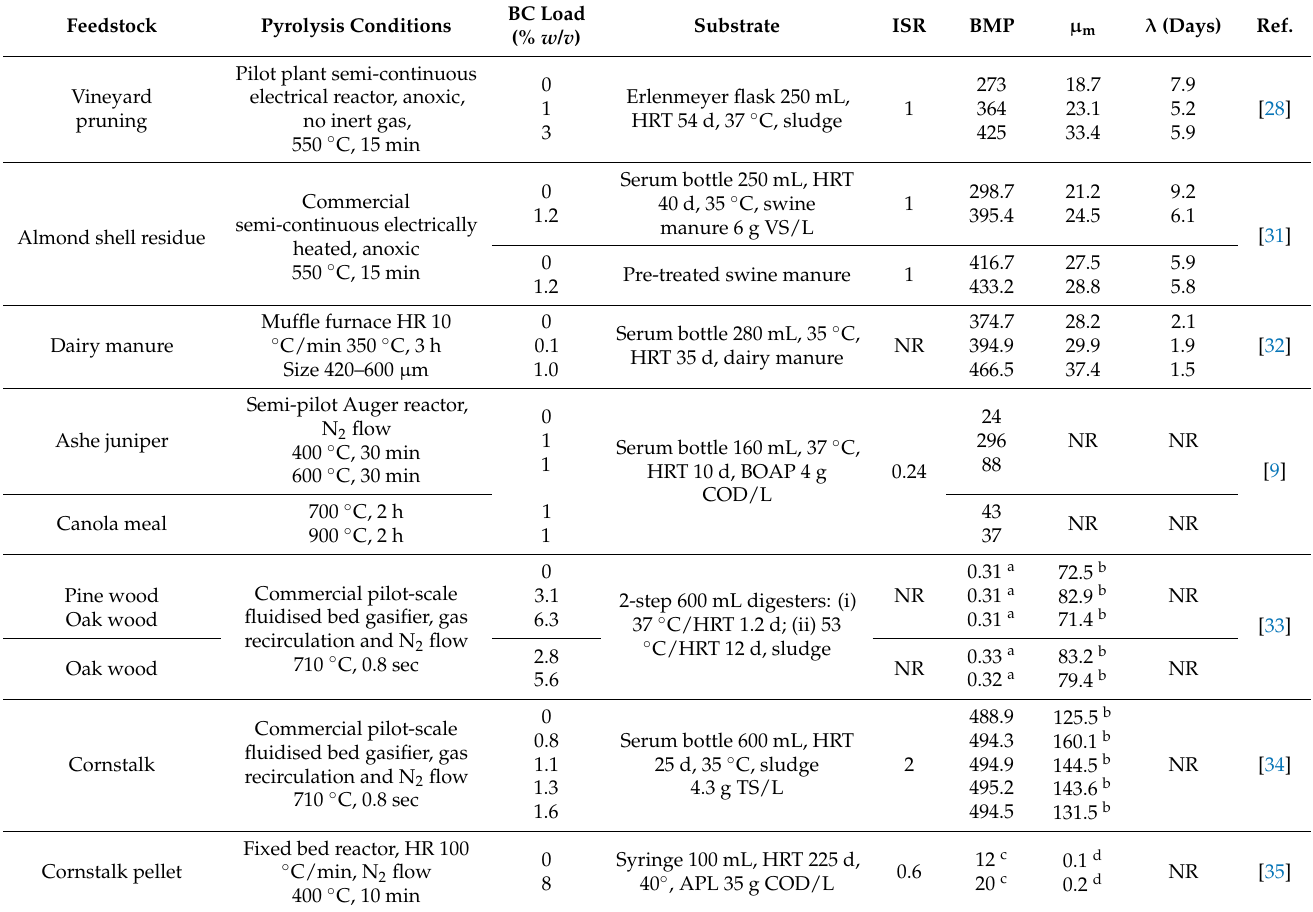
Table 3. Summary of the reports for the biochar addition on anaerobic digestion of sewage sludge, animal manure, bio-oil aqueous phase (BOAP) and aqueous pyrolysis liquid